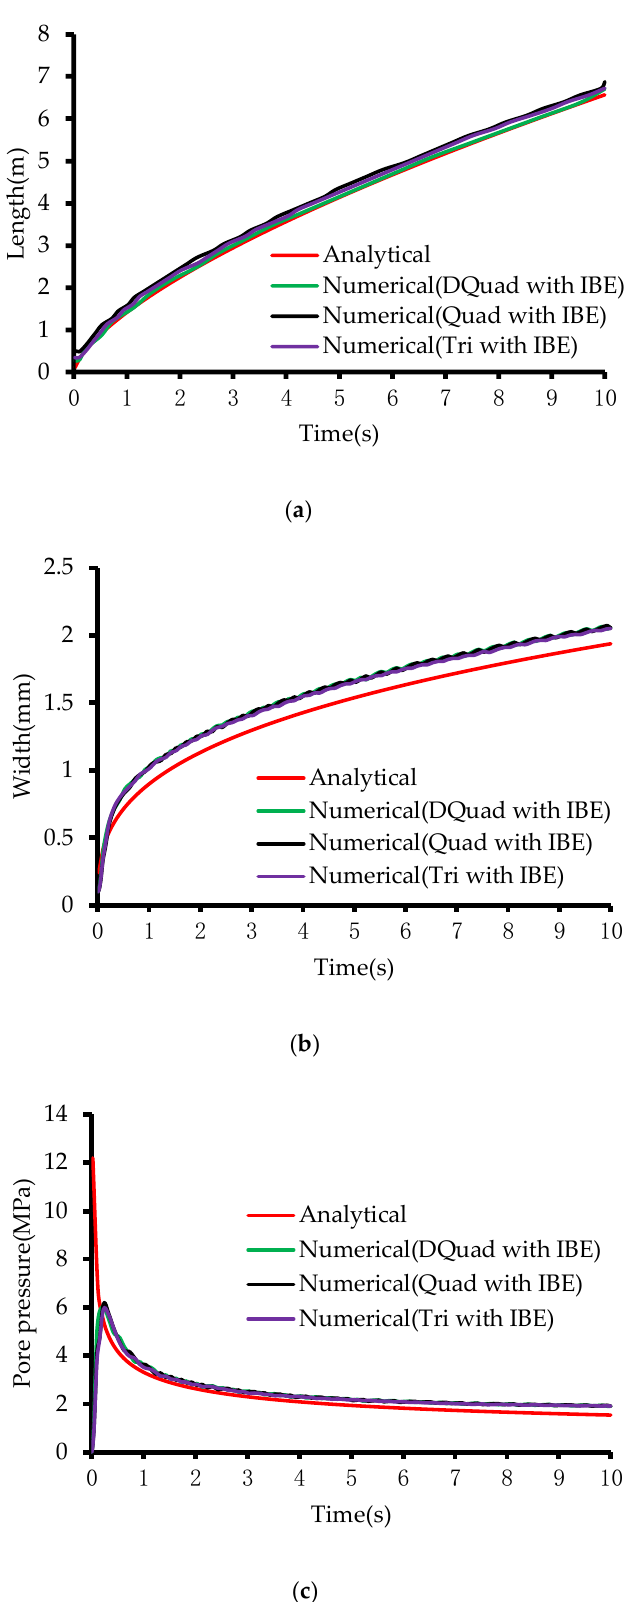
Figure 6. Comparison between numerical results with different mesh types and analytical results of large toughness. ( a ) Variation of fracture length with time; ( b ) fracture width at the injection point; ( c ) pore pressure at the injection point.